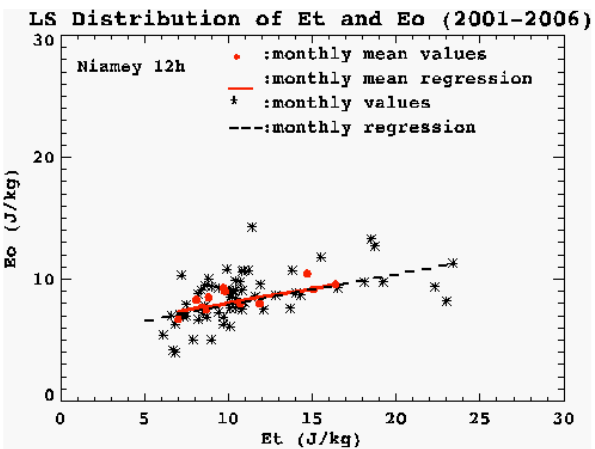
Fig. 4. Linear regression between E 0 and E T in the LS (19–23km) for Niamey at 12:00UT from January 2001 to December